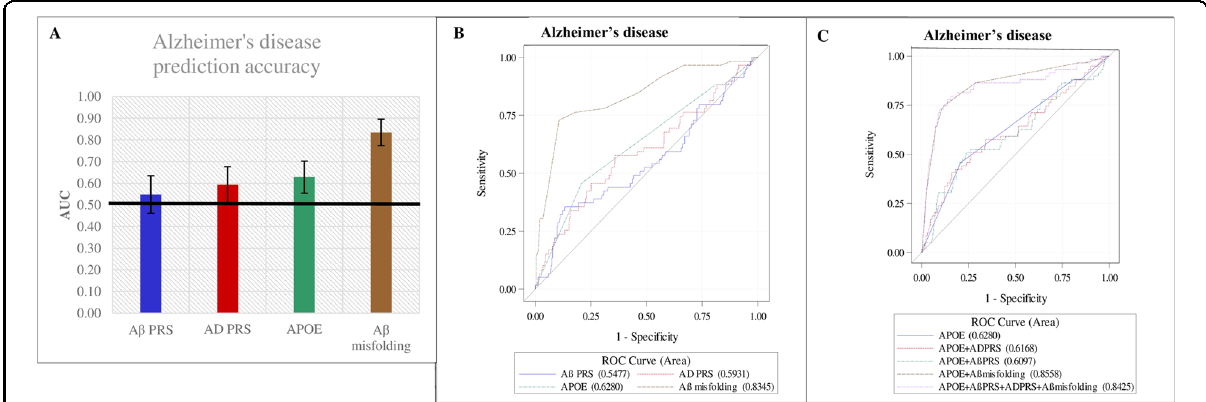
Fig. 2 Prediction of AD diagnosis within 14 years by A β PRS, AD PRS, APOE , and A β misfolding: ROC curve analysis. A Area under the curve (AUC) values with 95% con fi dence intervals (CIs); B receiver operating characteristic (ROC) curves for individual predictors; C ROC curves for comparison of each predictor to APOE. AD, Alzheimer ’ s disease; APOE , apolipoprotein E; PRS, polygenic risk score. B AUC, 95% CI: A β PRS: 0.55, 0.46 – 0.63; AD PRS: 0.59, 0.51 – 0.68; APOE : 0.63, 0.55 – 0.70; A β misfolding: 0.84, 0.78 – 0.90C) AUC, 95% CI: APOE : 0.63, 0.55 – 0.70; APOE + AD PRS: 0.62, 0.53 – 0.70; APOE + A β PRS: 0.61, 0.53 – 0.69; APOE + A β misfolding: 0.86, 0.80 – 0.91; APOE + AD PRS + A β PRS + A β misfolding: 0.84, 0.78 – 0.91. P -values for ROC contrast analysis between APOE alone and APOE + additional predictor: APOE - ( APOE + AD PRS): p = .52; APOE - ( APOE + A β PRS): p = .26;